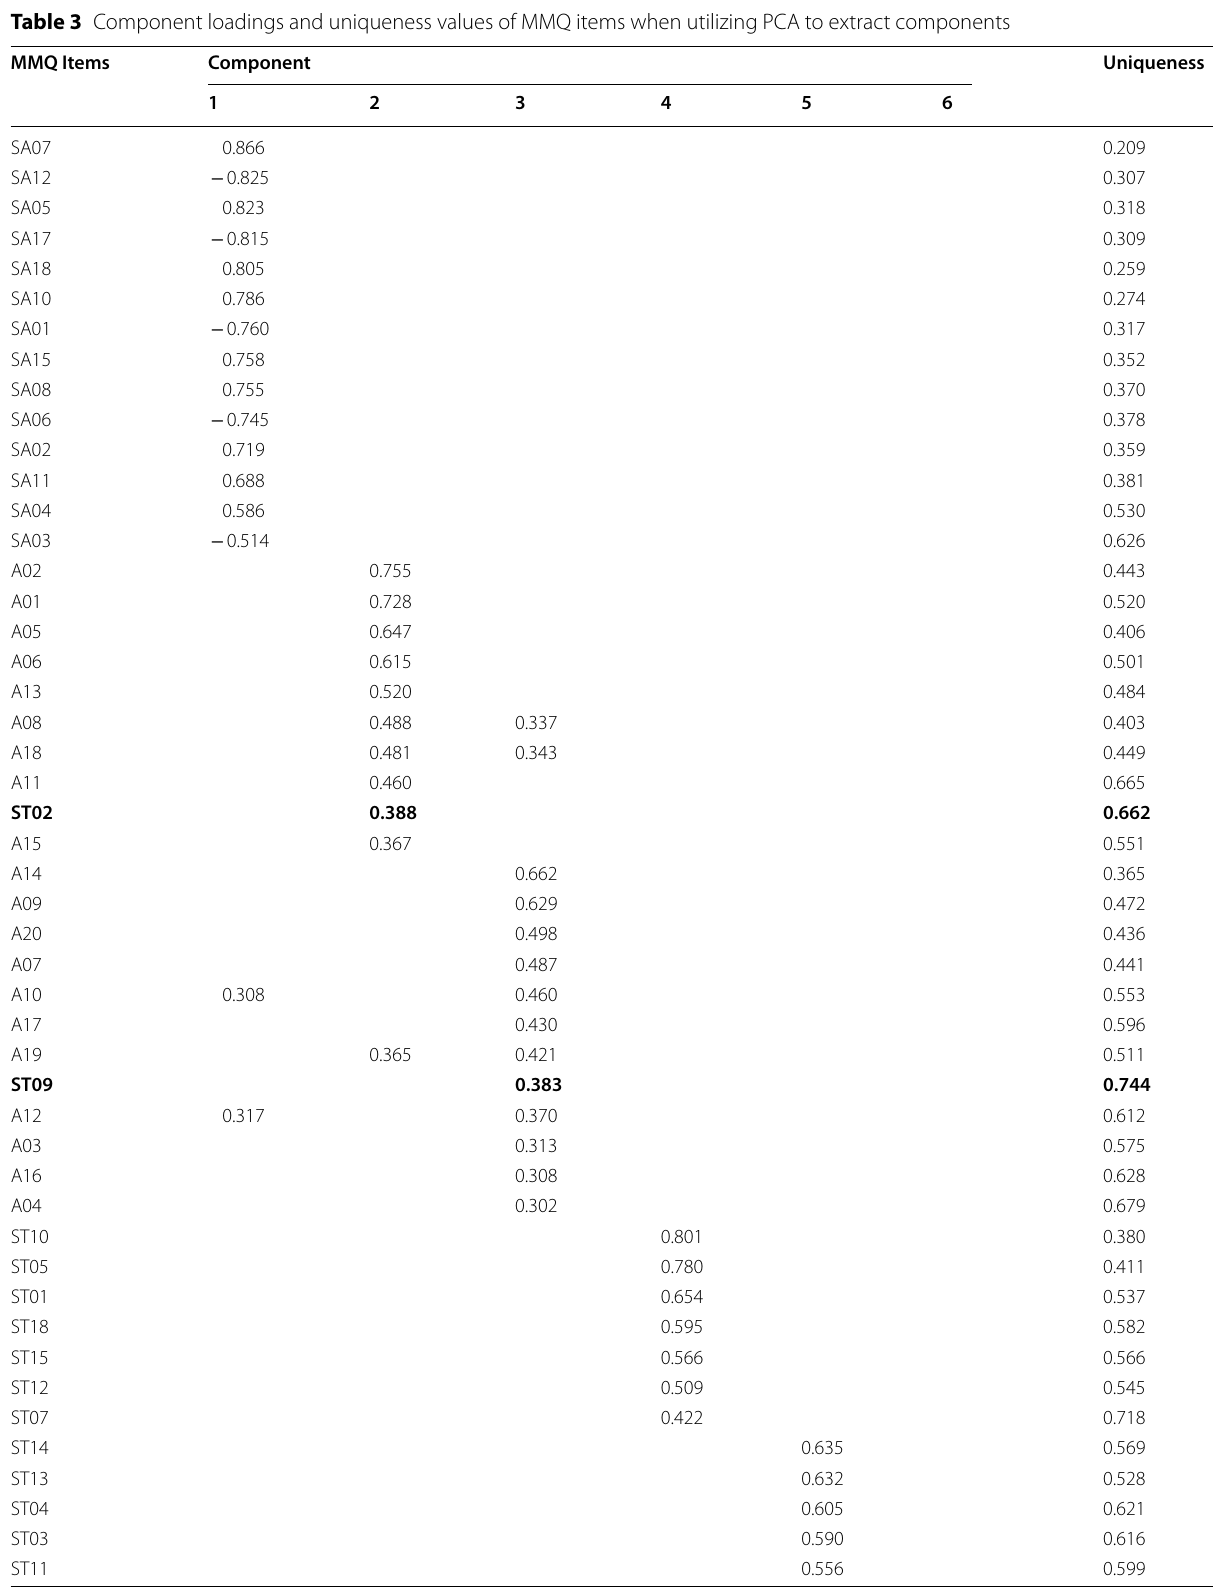
Table 3 Component loadings and uniqueness values of MMQ items when utilizing PCA to extract